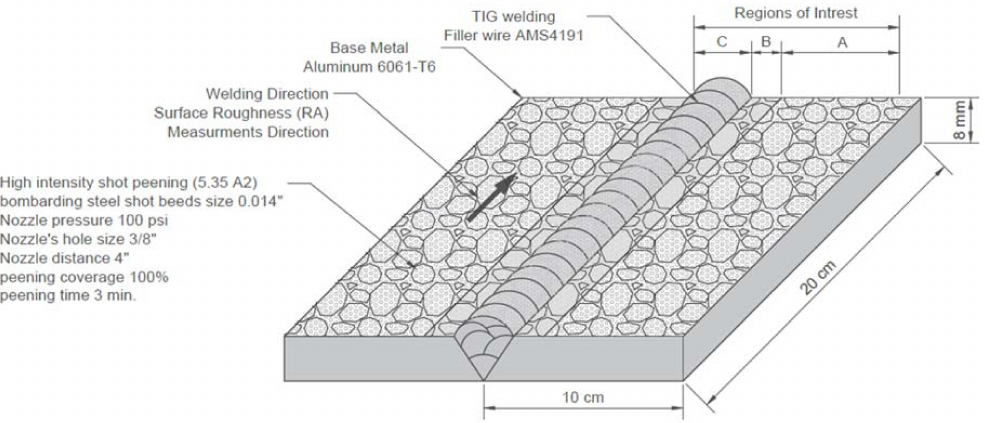
Figure 3. Geometry of Al6061-T6 high-intensity shot-peened, TIG-welded